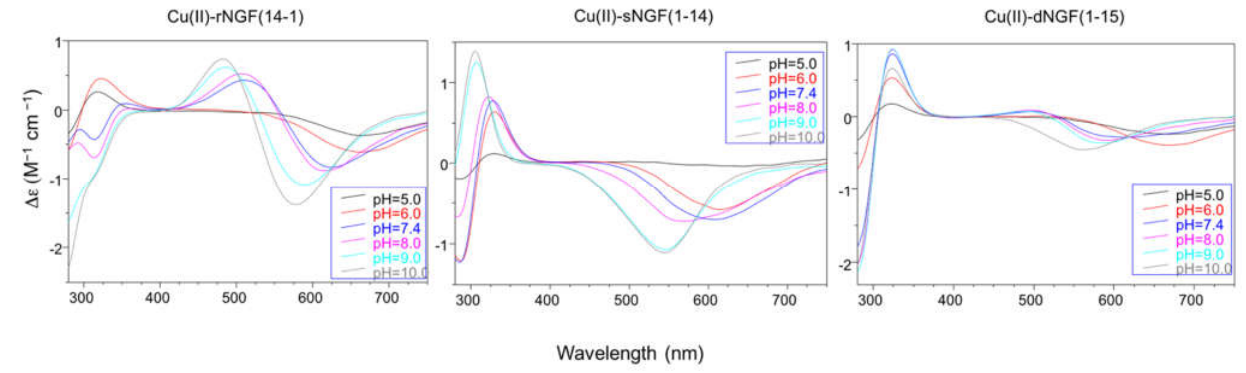
Figure 3. Circular Dichroism spectra with: rNGF(14-1), sNGF(1-14), and dNGF(1-15). [L] = 1 × 10 −3 M; metal to ligand molar